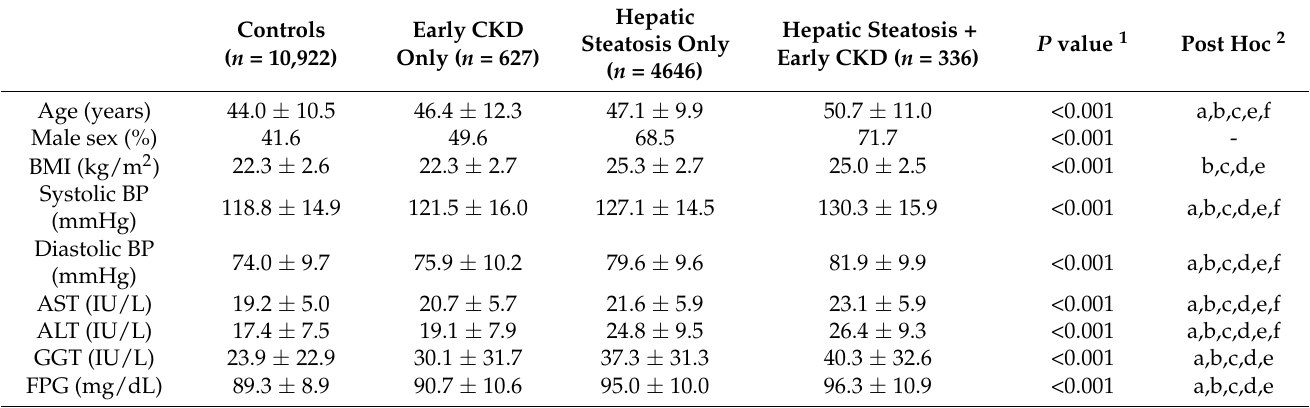
Table 1. Baseline characteristics of the study